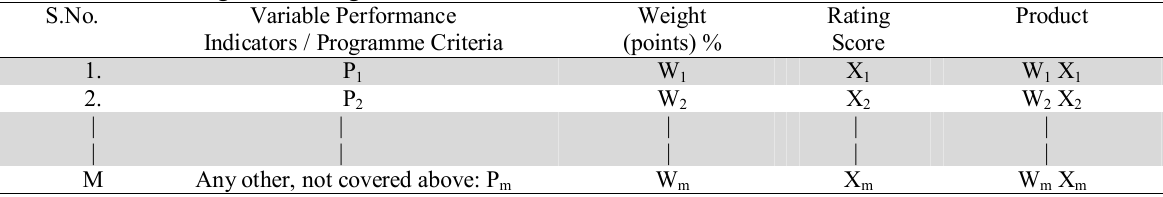
Calculation of weighted average of the score